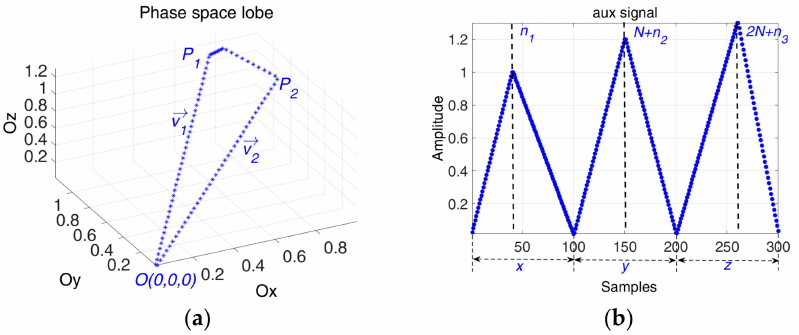
Figure 4. ( a ) The generated phase space lobe; ( b ) The corresponding aux signal based on Equations (5) and (7) with the following parameters: N = 100 , a 1 = 1, b 1 = 1.2, c 1 = 1.3, n 1 = 40, n 2 = 50, n 3 =